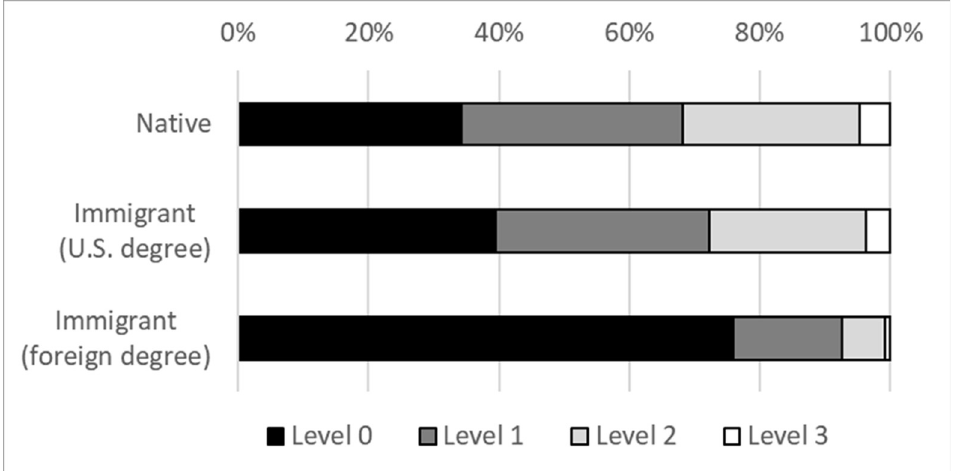
Fig 3. Distribution of PIAAC PSL category scores, education = any. The figure displays the percentage scoring at four different levels of the PST test. Higher levels require more sophisticated problem solving. The percentages are not age-adjusted.